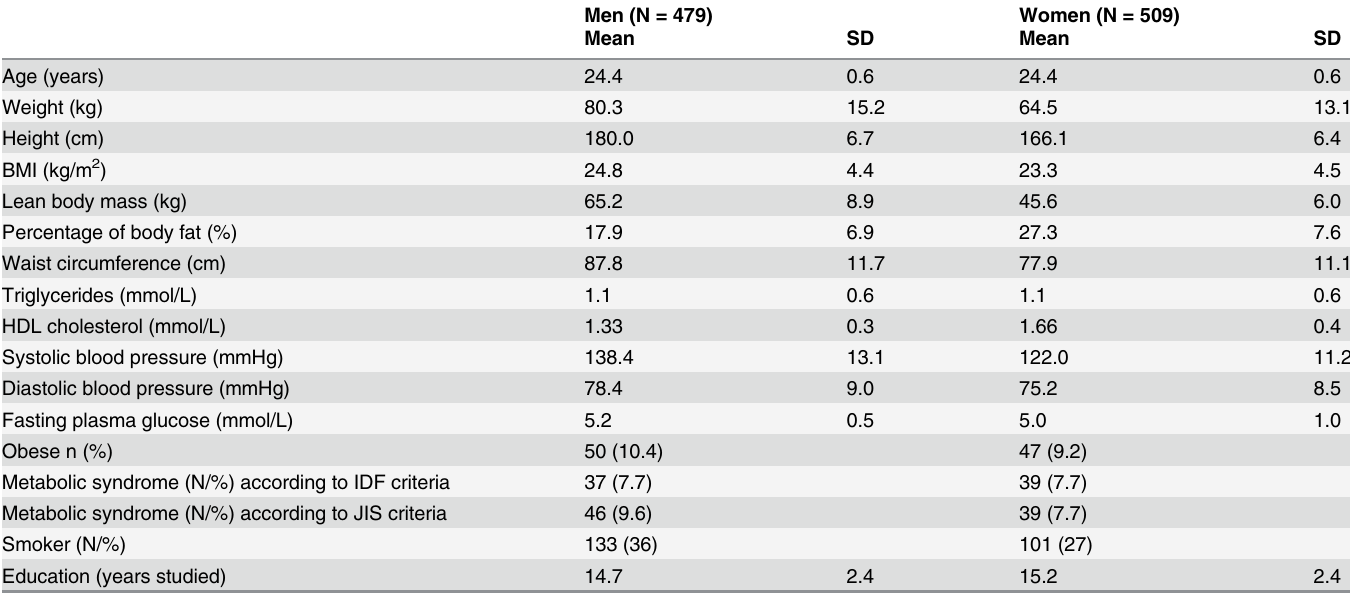
Table 1. Characteristics of 988 men and women.